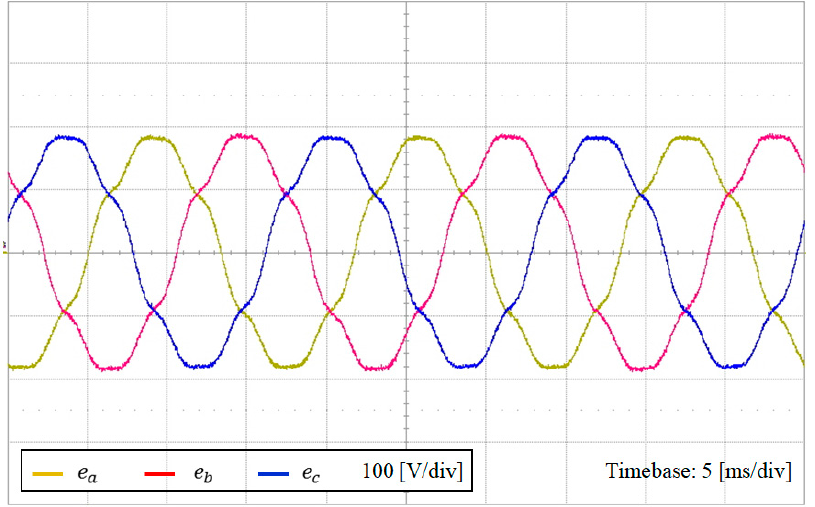
Figure 14. Distorted three-phase grid voltages used in the experiments.